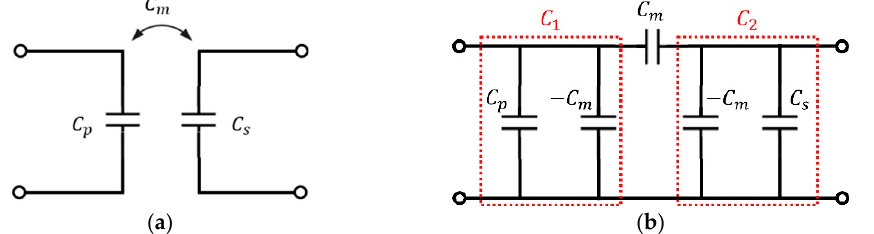
Figure 3. Physical coupler model.